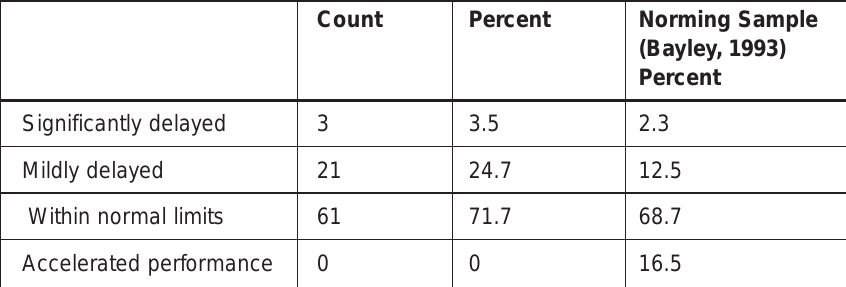
Table 2: Classification of performance based on the Psycho-motor score of the Bayley Scales of Infant